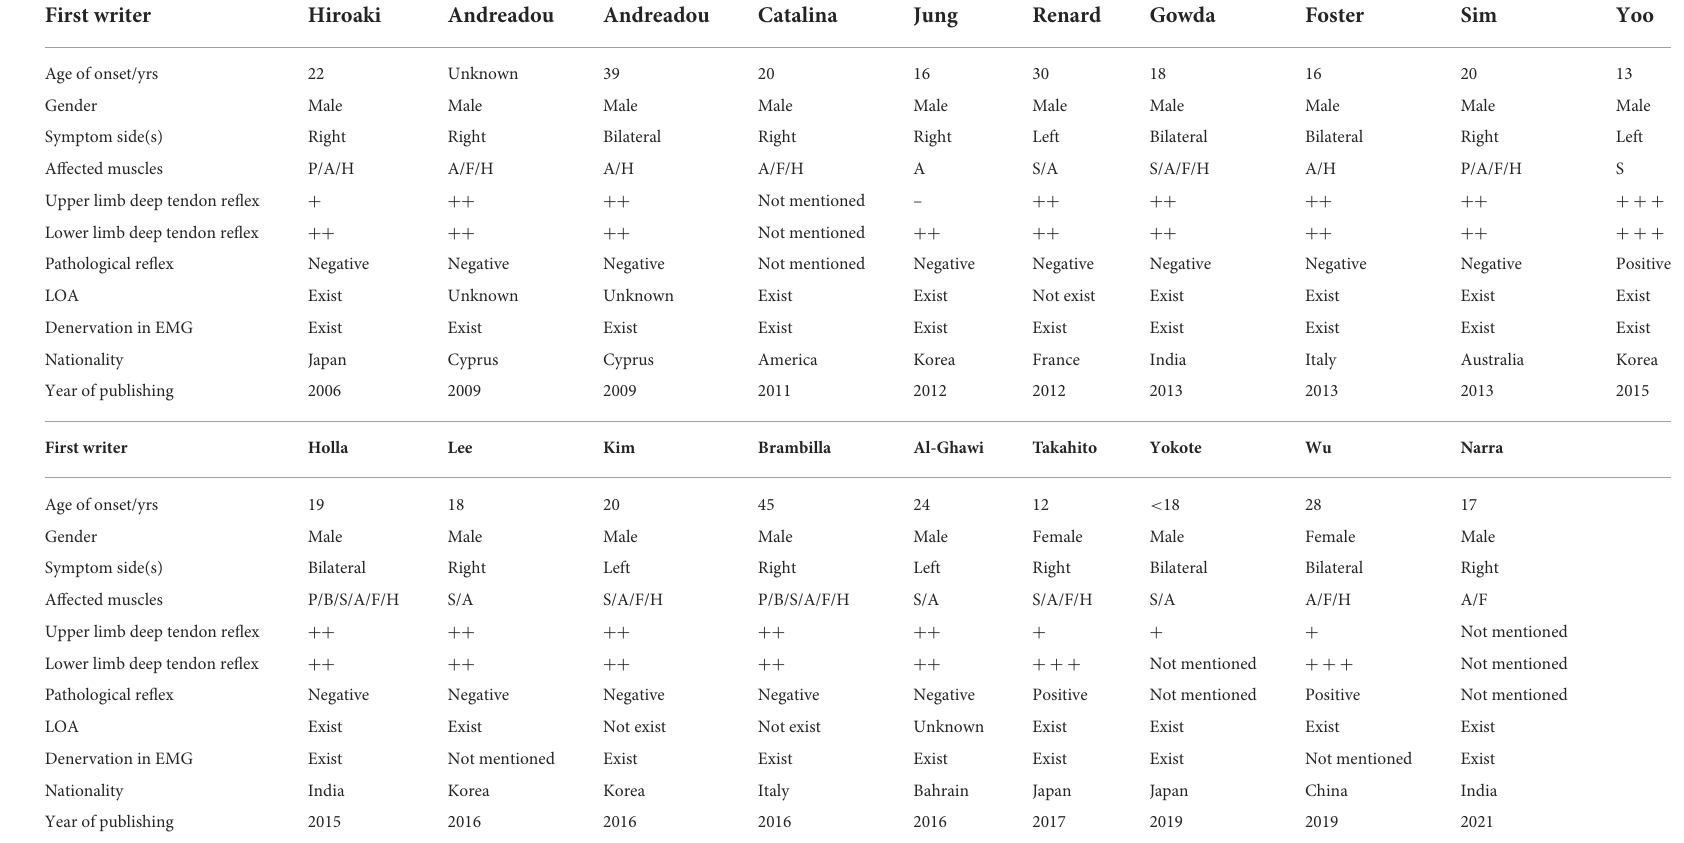
TABLE 4 Summary of proximal Hirayama disease case reports.